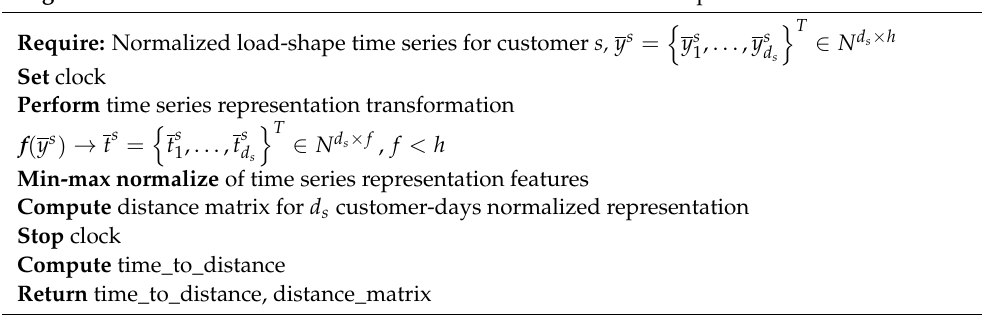
Algorithm A1 Time Series Transformation and Distance Matrix